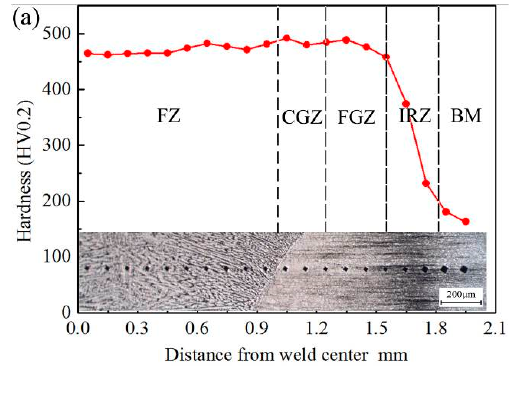
Figure 10. Grain morphology of FZ ( a ) welding speed 22 mm/s; ( b ) welding speed 40 mm/s and CGZ; ( c ) welding speed 22 mm/s; ( d ) welding speed 40 mm/s after quenching.